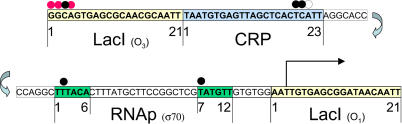
The Wild-Type
lac Promoter Region and the Point Mutations Used in This Study
Locations of point mutations are indicated by dots, where a red indicates mutations used in all variants, black means change to A or T with equal probability, and white means change to A, C, or T with equal probability. Also shown are the positions of the two LacI sites O1 and O3, the CRP site, and the RNAp site (−10 and −35 regions). Note that the promoter region is displayed in this figure in two parts: the sequence in the top part ends just downstream of the beginning of the sequence in the bottom part. The black arrow indicates the transcription start site of the
lacZ gene.